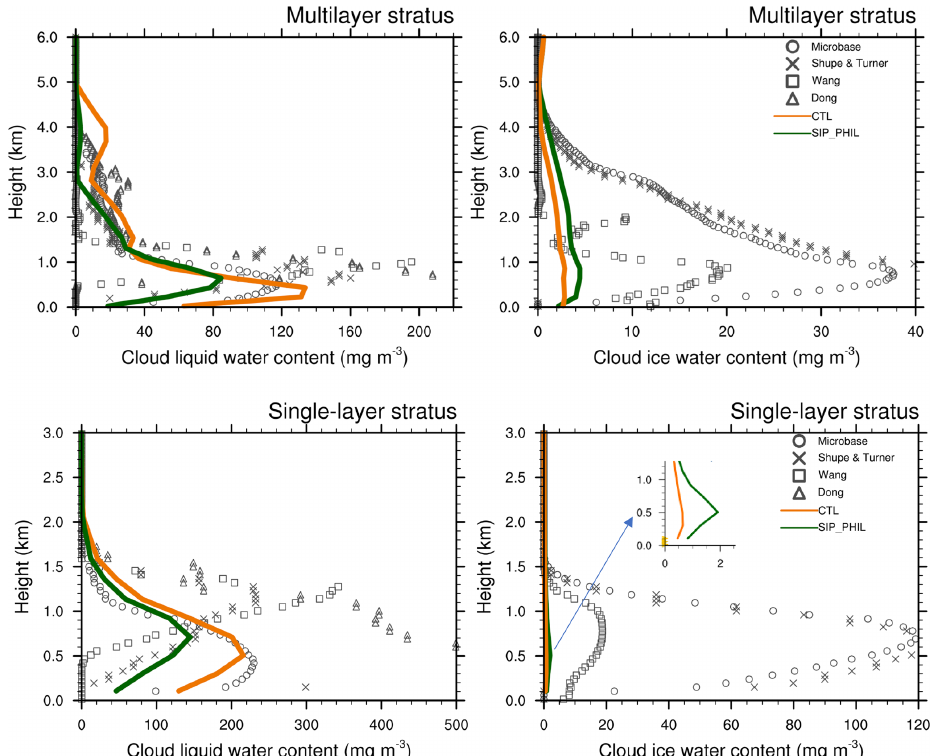
Figure 6. Vertical profiles of IWC and LWC during multilayer stratus and single-layer stratus periods from remote sensing retrievals shown by different markers, CTL experiment (solid orange line) and SIP_PHIL experiment (solid dark green